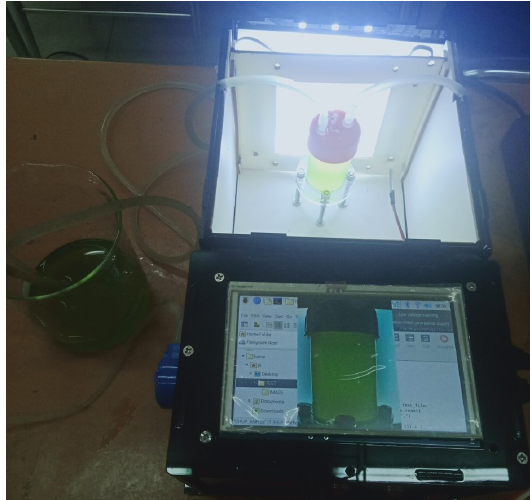
Figure 2. The low-cost system for capturing images of